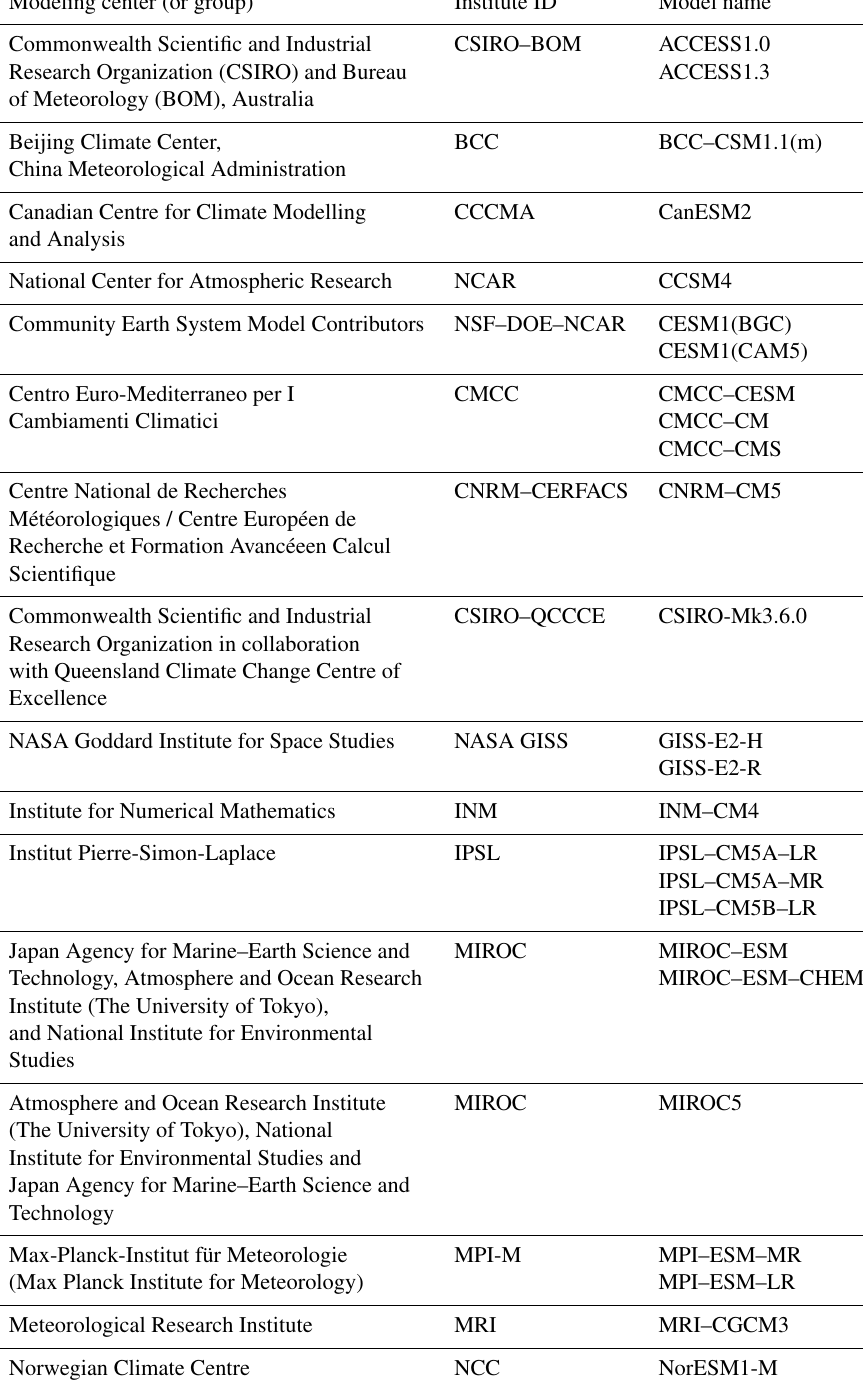
Table 1. List of CMIP5 models used in the literature (CMIP5, 2011; Taylor et al., 2012; Meehl et al., 2009; Hibbard et al.,